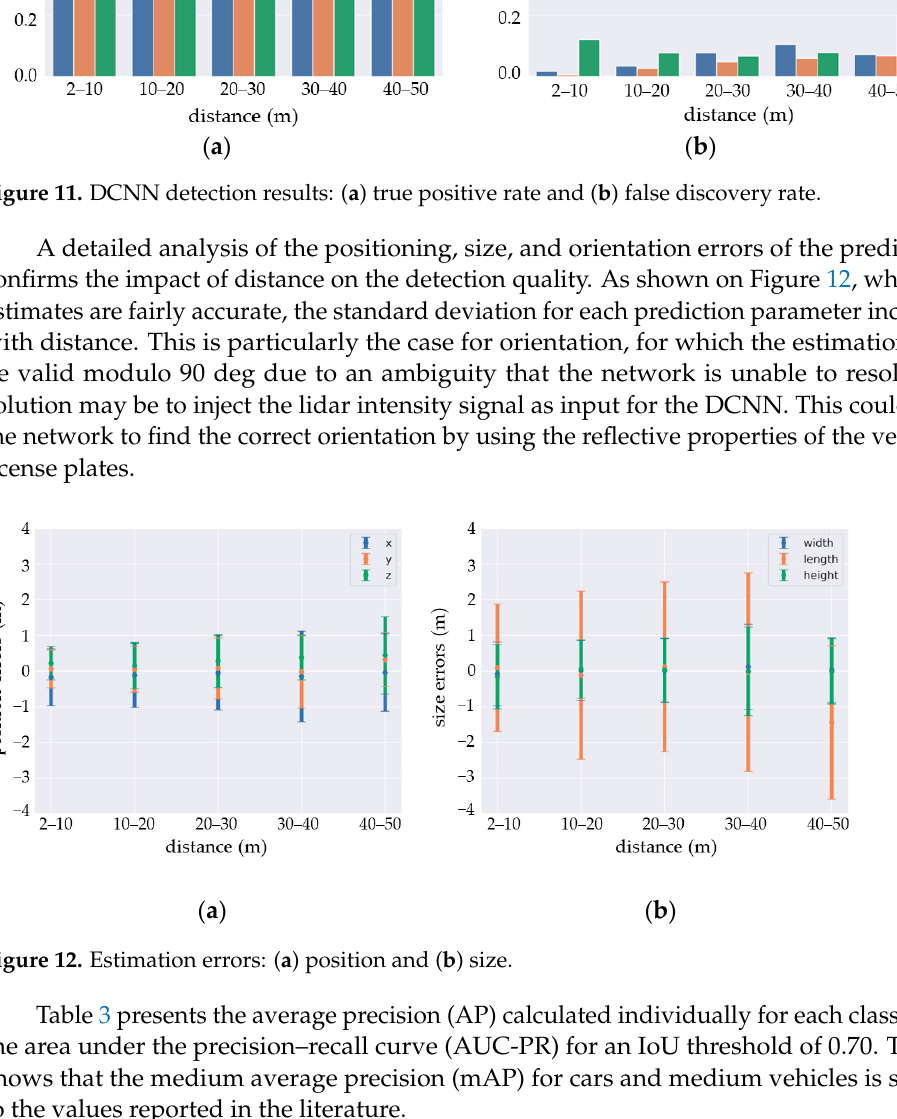
Table 3. Average precision results.